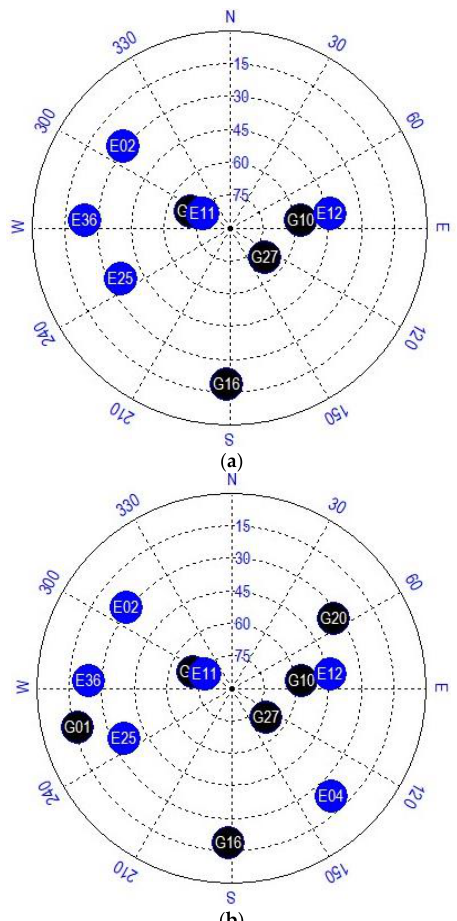
Figure 6. Skyplot of GPS/Galileo satellite at CAS1 station. ( a ) The traditional optimal subset selection method of PAR and ( b ) the proposed optimal subset selection method of PAR.